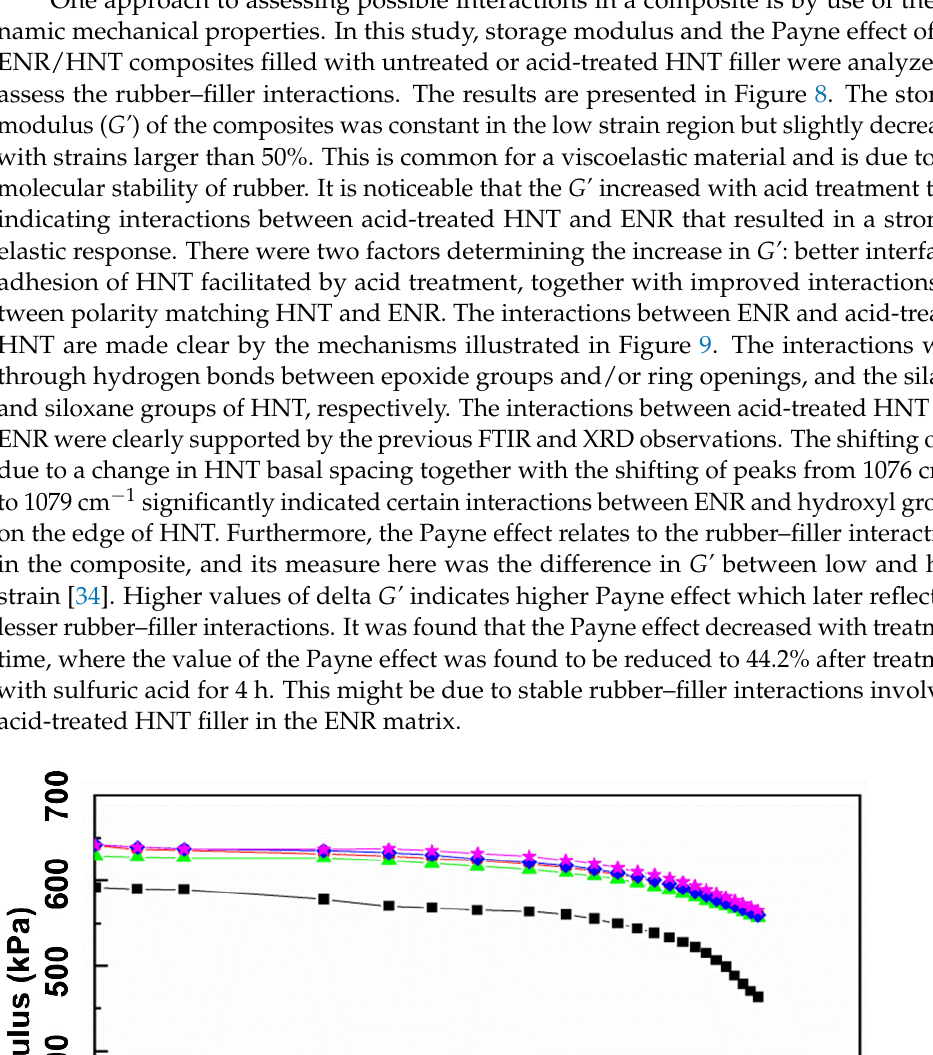
Figure 9. Possible interactions of ENR with acid-treated HNT filler. 3.6. Mechanical Properties and Corresponding Morphologies Figure 10 shows the stress–strain curves of the ENR composites filled with untreated and acid-treated HNT. The stress–strain curves show the SIC. A higher stress response was found for the composites filled with acid-treated HNT, suggesting that the samples